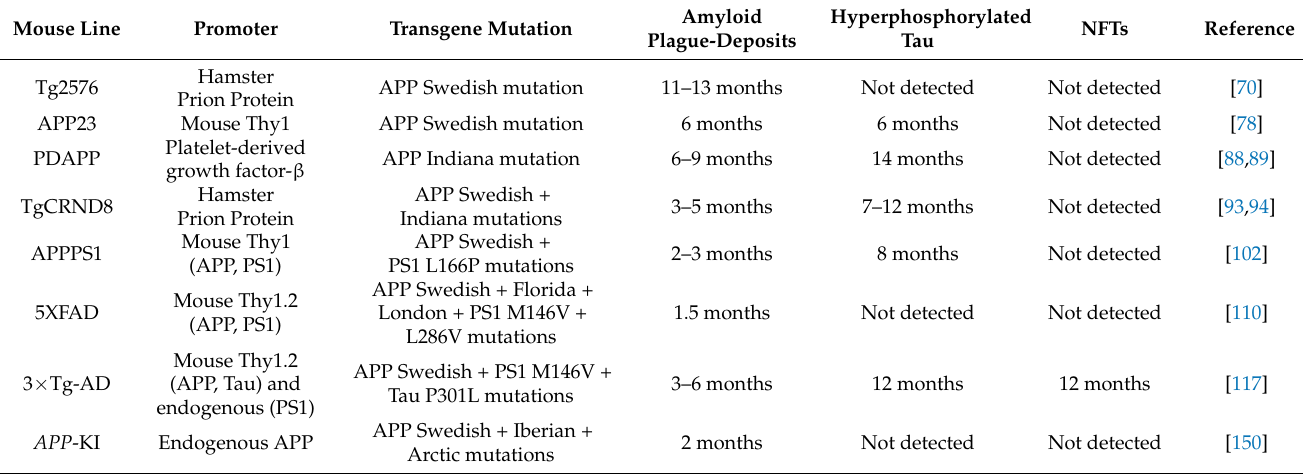
Table 2. Summary of representative APP-Tg and APP -KI mice in AD model